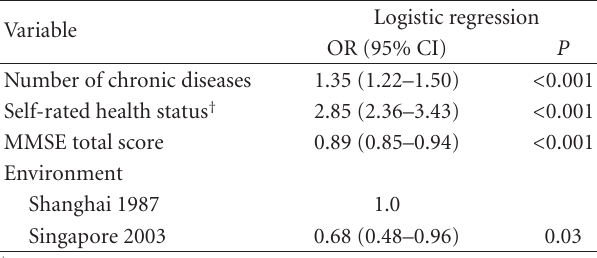
Table 2: The independent contributions of health variables and environment to disability ∗ : combined analysis.